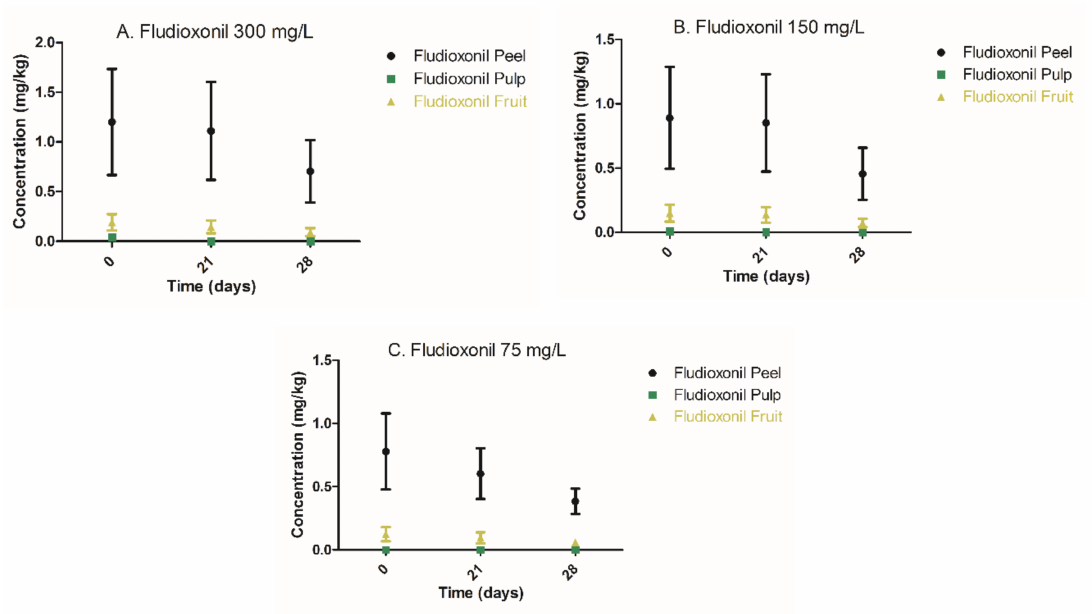
Figure 4. Fludioxonil depletion kinetics in peel, pulp, and whole fruit following spray application of Reed avocado in ( A ) 300 mg / L, ( B ) 150 mg / L, and ( C ) 75 mg / L formulation solution (Scholar ® ). ( A ) Fludioxonil (300 mg / L) depletion in peel, pulp, and whole fruit; ( B ) Fludioxonil (150 mg / L) depletion in peel, pulp, and whole fruit; ( C ) Fludioxonil (75 mg / L) depletion in peel, pulp, and whole